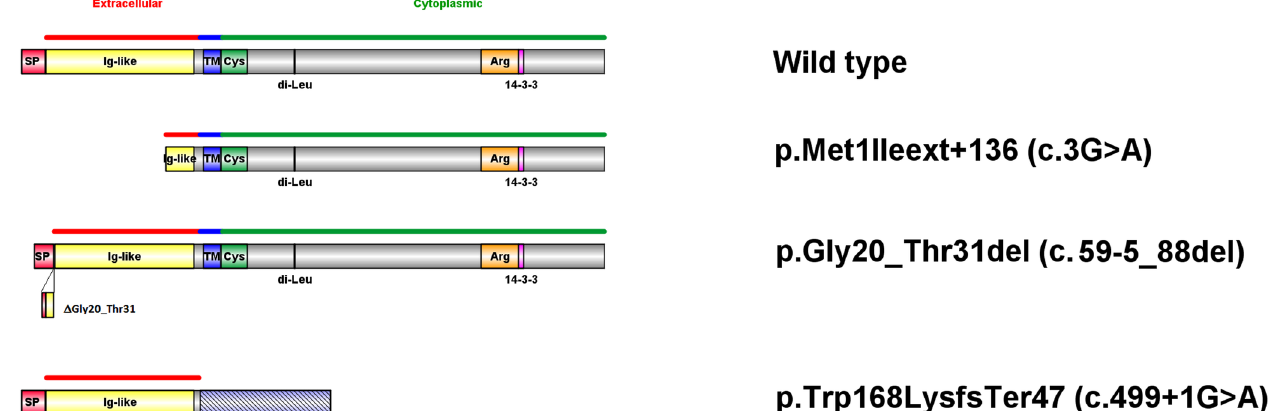
Fig 3. In silico analysis and predicted effect at the protein level of c.3G > A, c.59-5_88del and c.499+1G > A